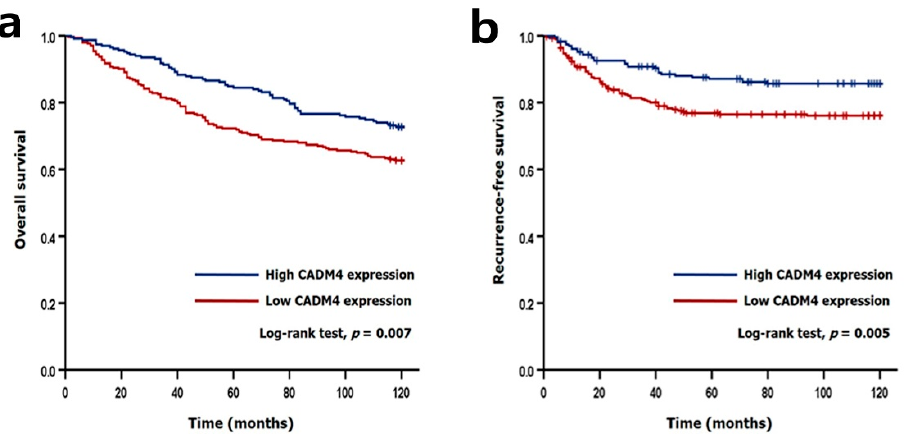
Figure 2. Kaplan–Meier analyses for overall survival ( a ) and recurrence-free survival ( b ). Overall survival and recurrence-free survival were significantly worse in patients with low CADM4 expression (Log-rank test, p = 0.007 and p = 0.005, respectively). Table 4. Univariate and multivariate Cox regression analyses among gastric adenocarcinoma patients ( n =